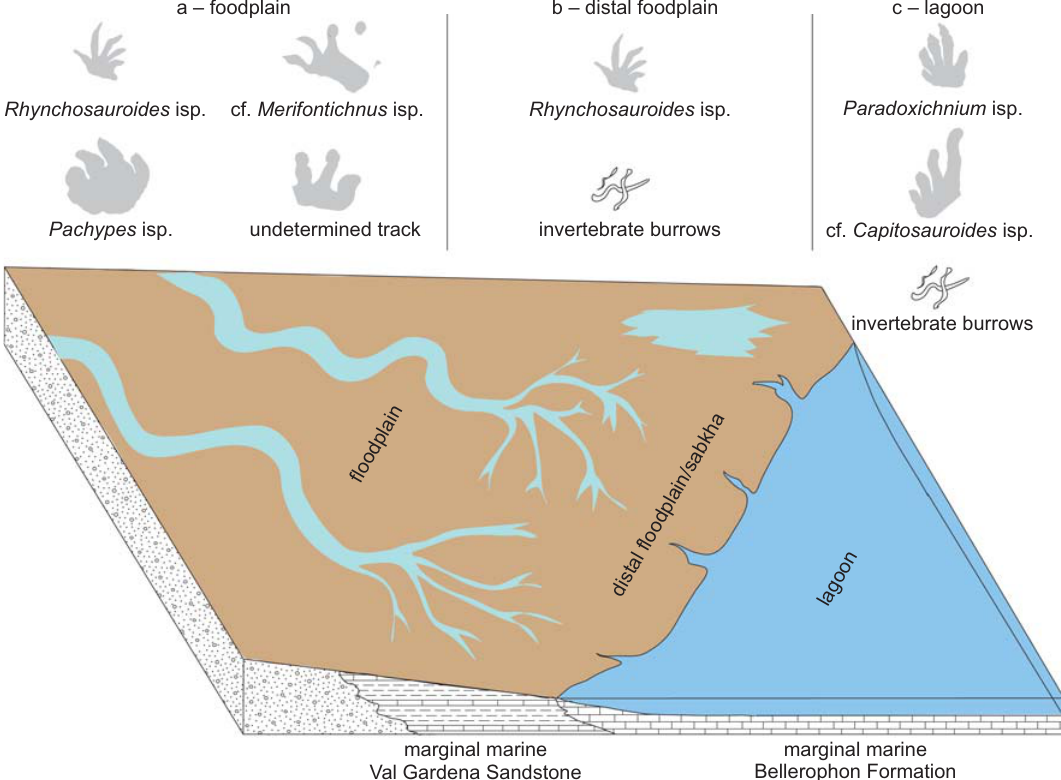
Fig. 9. Trace fossils and an interpretation of the depositional environment of the footprint localities of Recoaro (facies associations a–c).